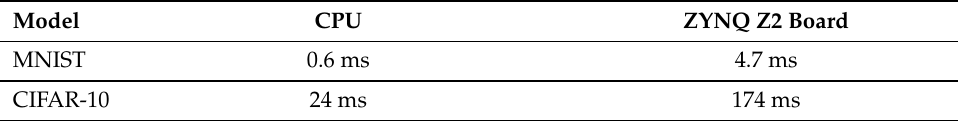
Table 2. Execution Time for different platforms and models, integer 16.